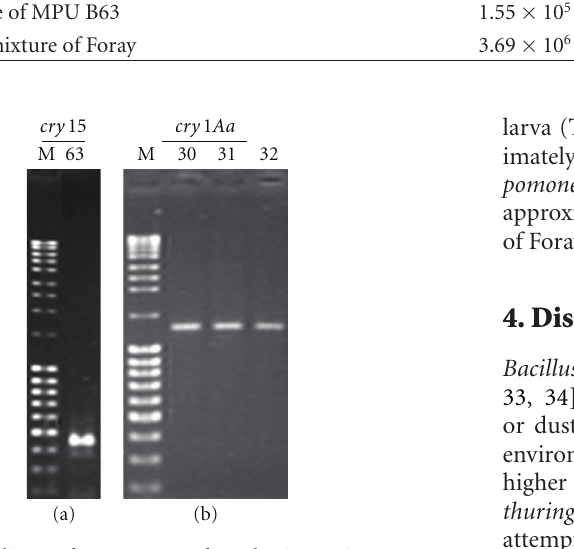
Figure 1: Amplicon of cry15 gene of B. thuringiensis MPU B63 strain is presented in panel a on the left. Amplicons of cry1Aa gene of B. thuringiensis MPU B30, MPU B31, and MPU B32 strains are presented in panel b on the right. Lanes: M. MassRuler DNA Ladder, Mix (10000, 8000, 6000, 5000, 4000, 3000, 2500, 1500, 1031, 900, 800, 700, 600, 500, 400, 300, 200 bp), 63. B. thuringiensis MPU B63, 30. B. thuringiensis MPU B30, 31. B. thuringiensis MPU B31, 32. B. thuringiensis MPU